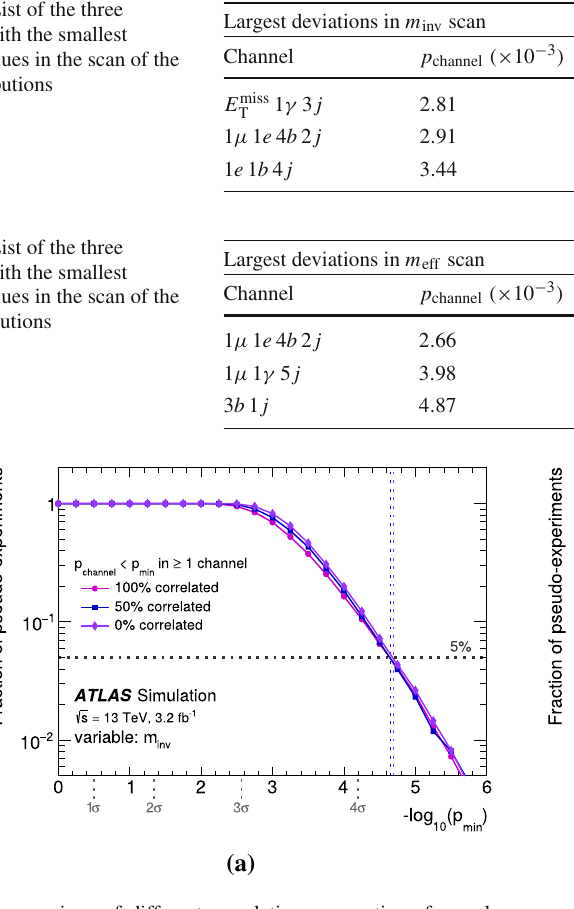
areshownontheleft( a ),whilethefractionsinthescanofthe m eff distri- bution having at least three p channel -values smaller than p min are shown on the right ( b